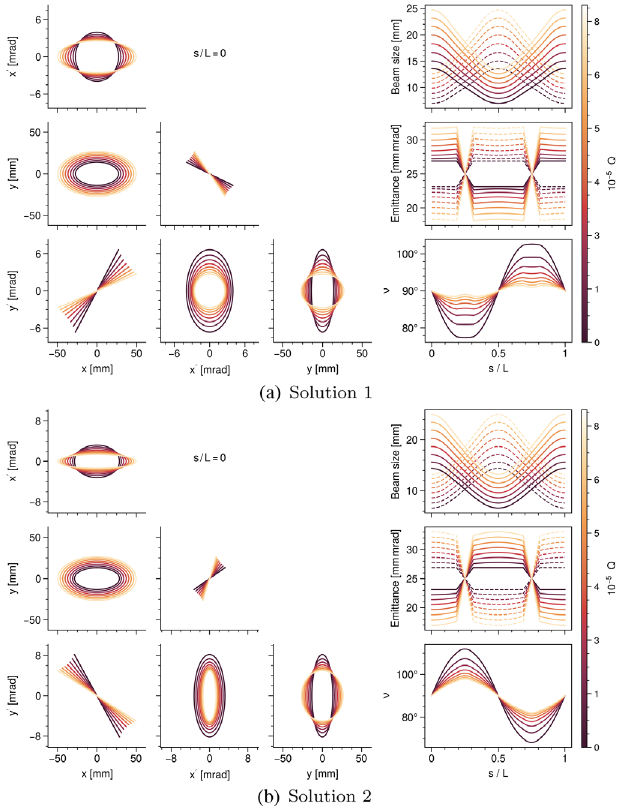
FIG. 12. Matched solution in a coupled FODO lattice as space charge is increased with (a) ε 2 ¼ 0 and (b) ε 1 ¼ 0 . The lattice is coupled due to solenoid magnets inserted between the quadru- poles. Left: phase space projections at the lattice entrance. Right: beam parameters within the lattice. Solid lines are for x and dashed lines are for y in the top two